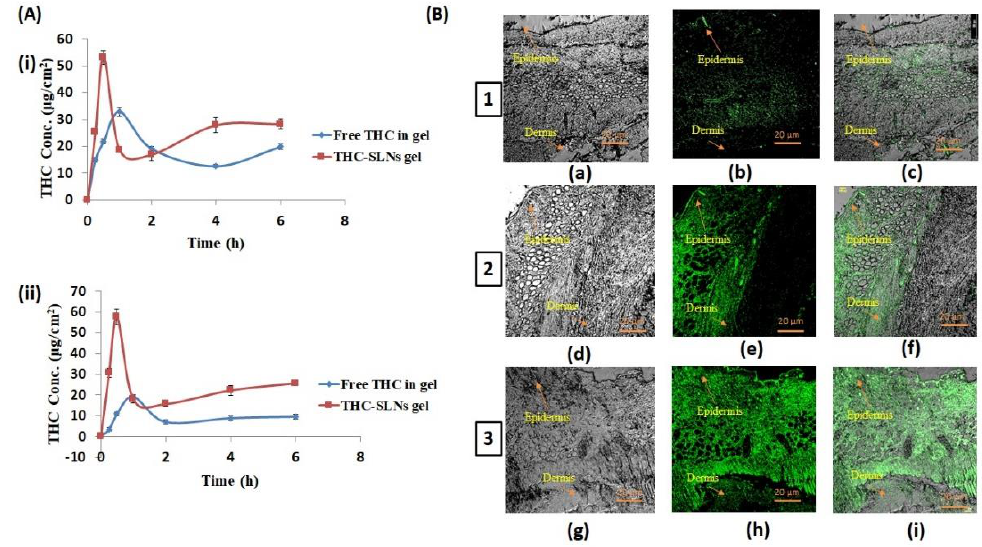
Figure 5. ( A ) (i) The THC concentration ( µ g/cm 2 ) versus time (h) profile at various time points in the epidermal layer of the skin. (ii) The THC concentration ( µ g/cm 2 ) versus time (h) profile at various time points in the dermal layer of the skin after treatment with THC-SLN gel and free THC in gel. All values are expressed as mean ± SD ( n = 3). ( B ) Confocal laser scanning microscopy images showing the distribution of 5,6-carboxyfluorescein in the skin at the end of 24 h of treatment: (1) skin treated with free 5,6-carboxyfluorescein in a Carbopol gel base, (2) skin treated with free 5,6- carboxyfluorescein and blank SLN gel in combination and (3) skin treated with 5,6-carboxyfluorescein-loaded CFC-SLN gel. ( Note: Images (a,d,g) were taken by bright-field microscopy; (b,e,h) indicate detection of 5,6-carboxyfluorescein; and (c,f,i) indicate the overlap of these two images). Table 3. Various dermatokinetic parameters from concentration time profiles in the epidermises and dermises of Wistar rats after treatment with THC-SLN gel and free THC gel.